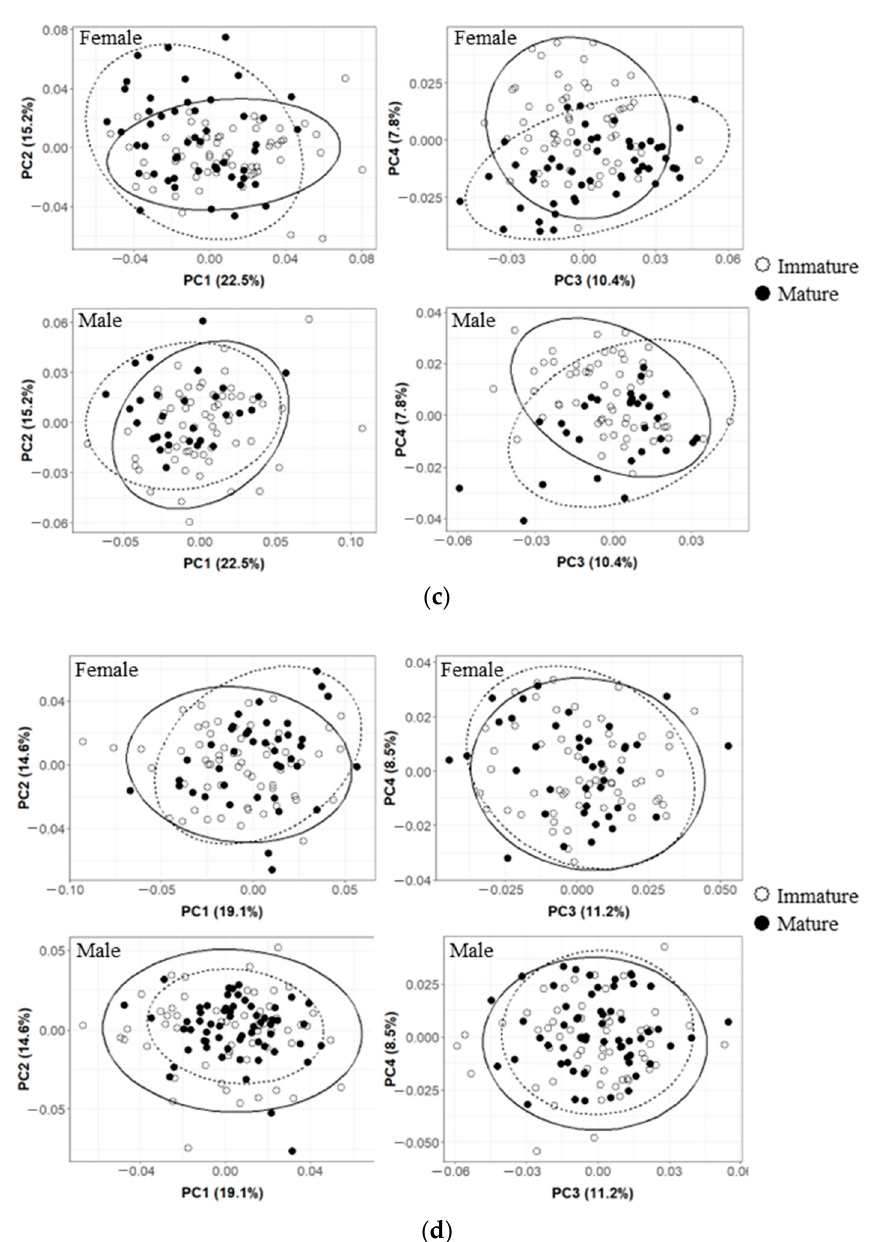
Figure 3. Results of principal component analysis (PCA) of upper beak of the four cephalopods, showing the first principal component (PC1) versus (PC2) and (PC3) versus (PC4) shape variation with 95% ellipse confidence intervals of immature (solid line) and mature (dashed line) beaks. ( a ) Octopus minor . ( b ) Uroteuthis edulis . ( c ) Sepia esculenta . ( d ) Sthenoteuthis oualaniensis .